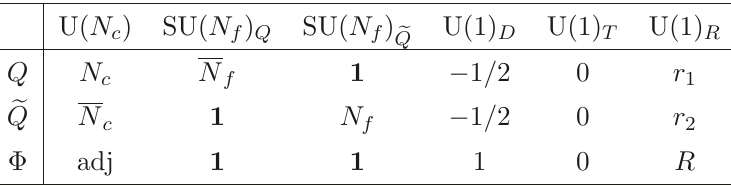
Table 2 . Matter contents of 3d N = 2